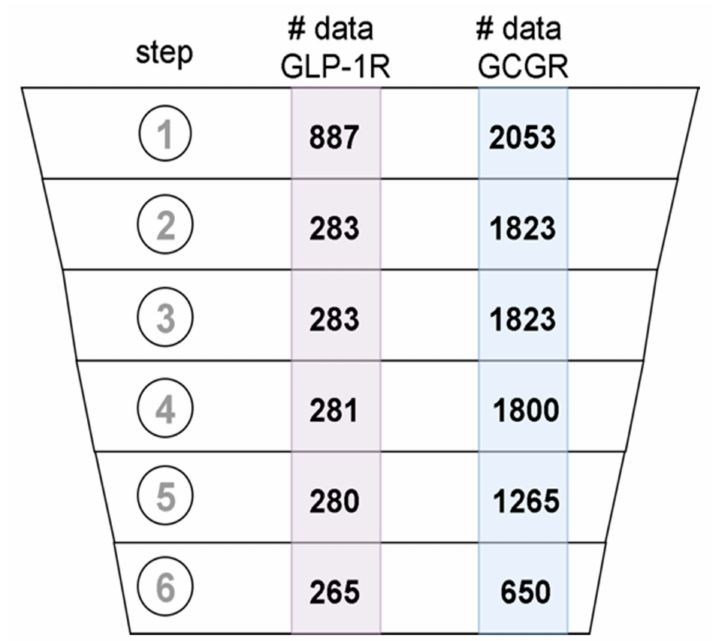
Figure 9. Data records that passed subsequent data curation steps: (1) data acquisition, (2) removing records with no SMILES included, (3) removing records with Confidence Score <8, (4) keeping only records from large assays, (5) removing records without numerical value for desired property, and (6) duplicates